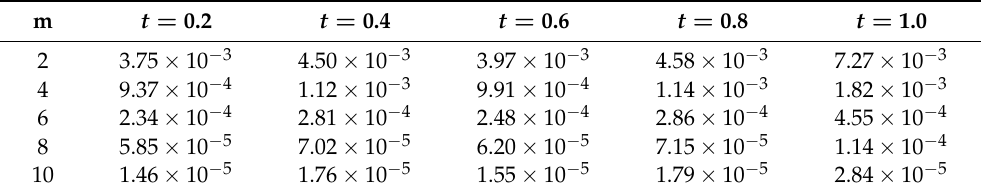
Table 6. L 2 norm of errors taking r = 3, J = 2, θ = 1/2 and δ t = 0.1/2 m − 1 for Example 2. m t = 0.2